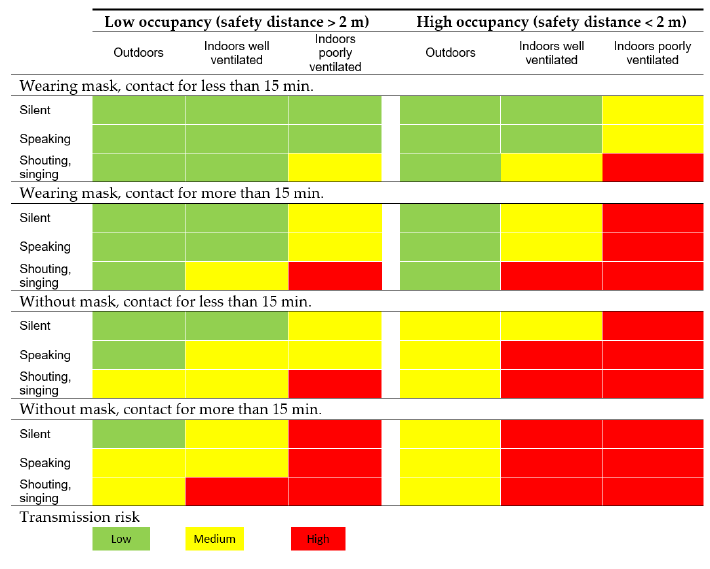
Figure 1. COVID-19 risk transmission in different situations .